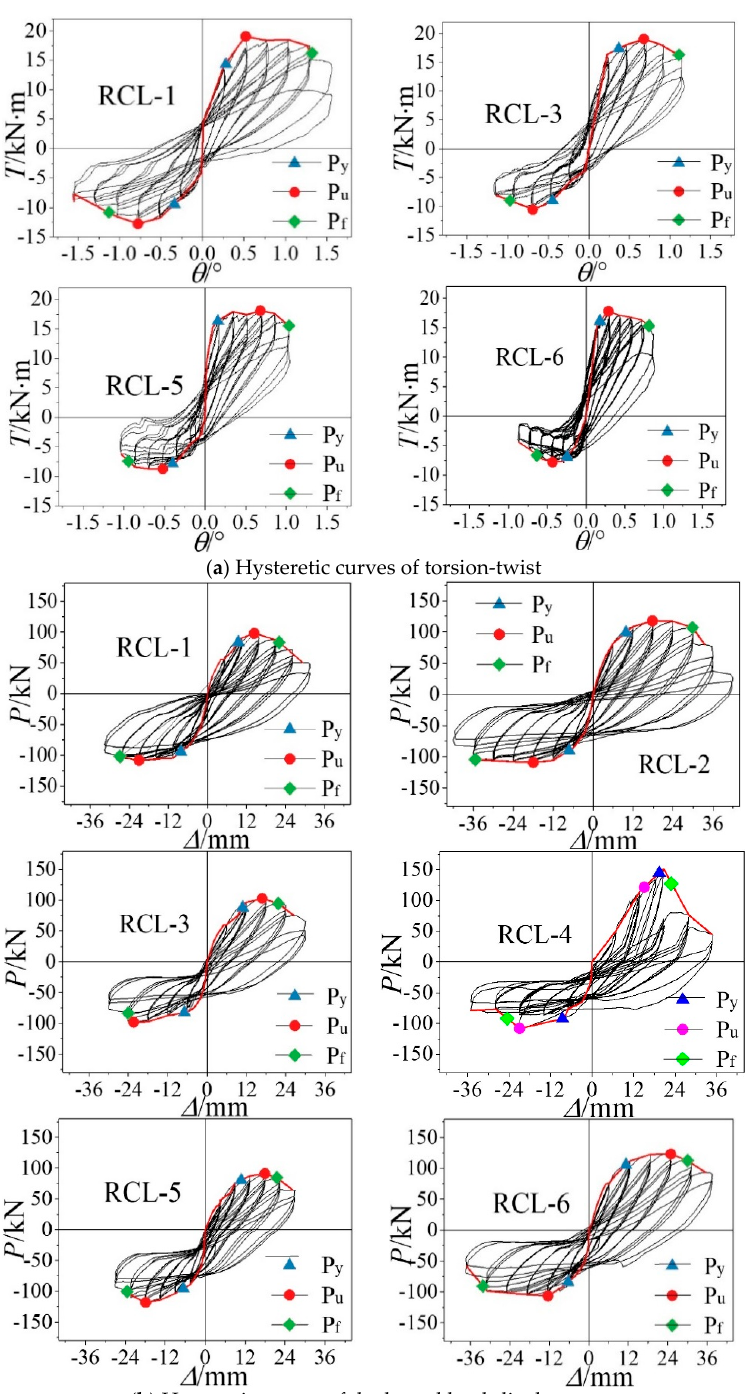
Figure 7. Hysteretic curves of the torsion-twist and load-displacement.